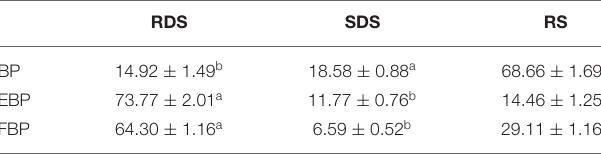
TABLE 7 | Content of TS, RDS, SDS and RS of BP, EBP, and FBP